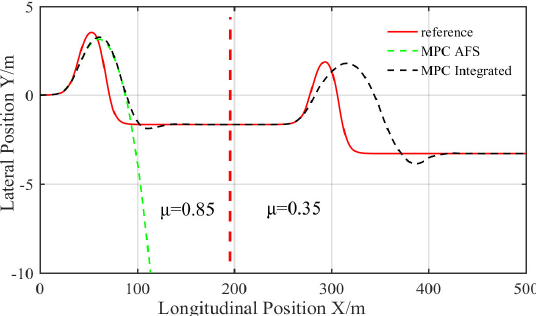
Figure 13. Comparison between the actual and reference paths at higher speed ( 110km/h